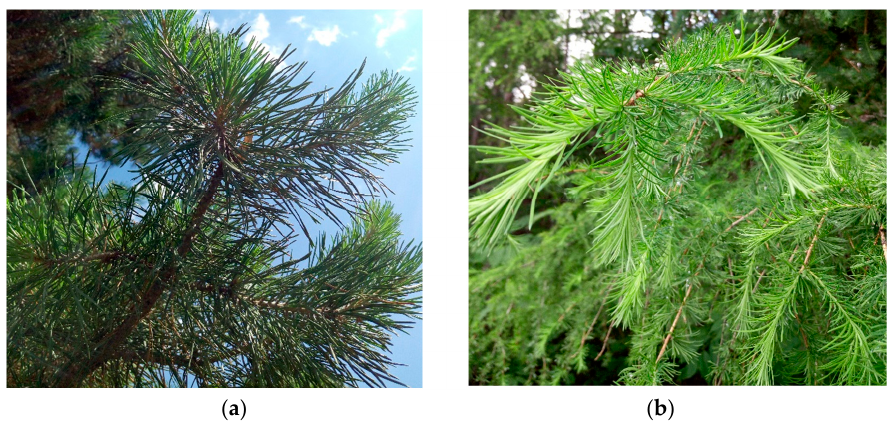
Figure 2. Graphic representation: ( a ) Scotch pine; ( b ) Larch pine.